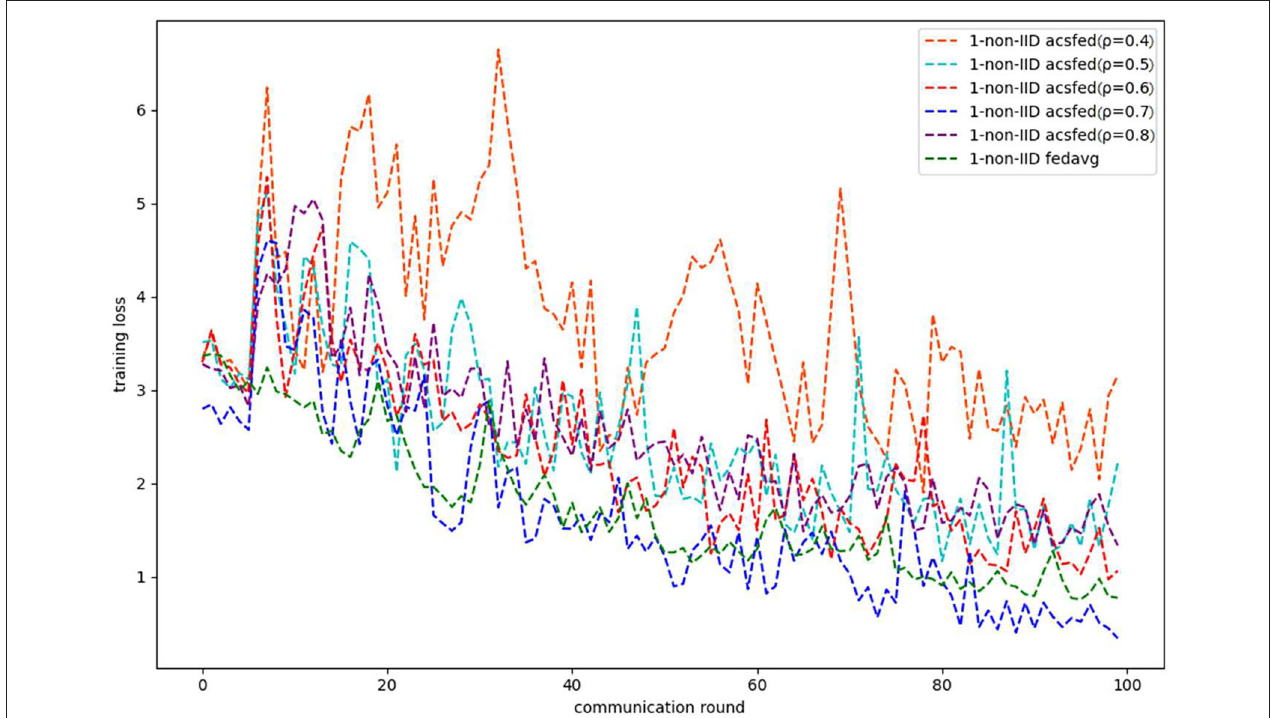
FIGURE 3 | Training loss on MNIST in the 1-class non-IID scenario.